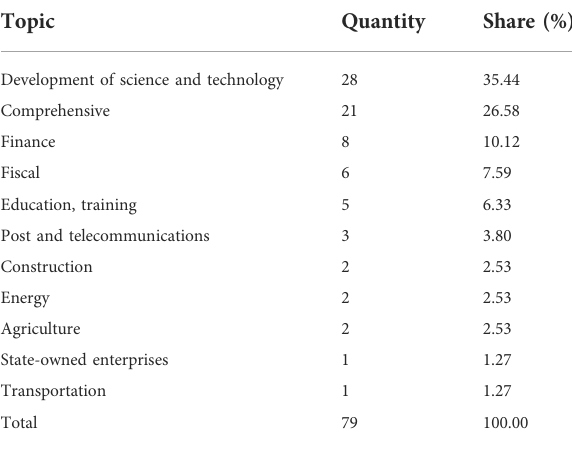
TABLE 3 Topic,quantity, and percentage share oflocal legislation and